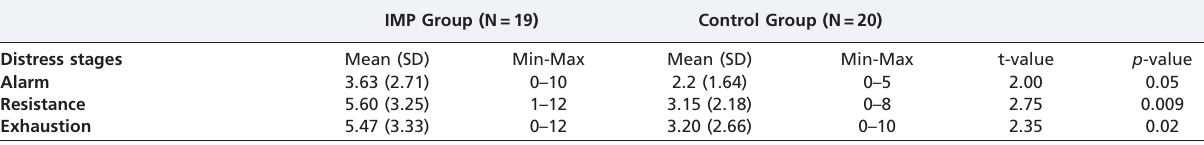
Table 3 - Lipp’s Stress Symptoms Inventory for Adults (LSSI; mean ¡